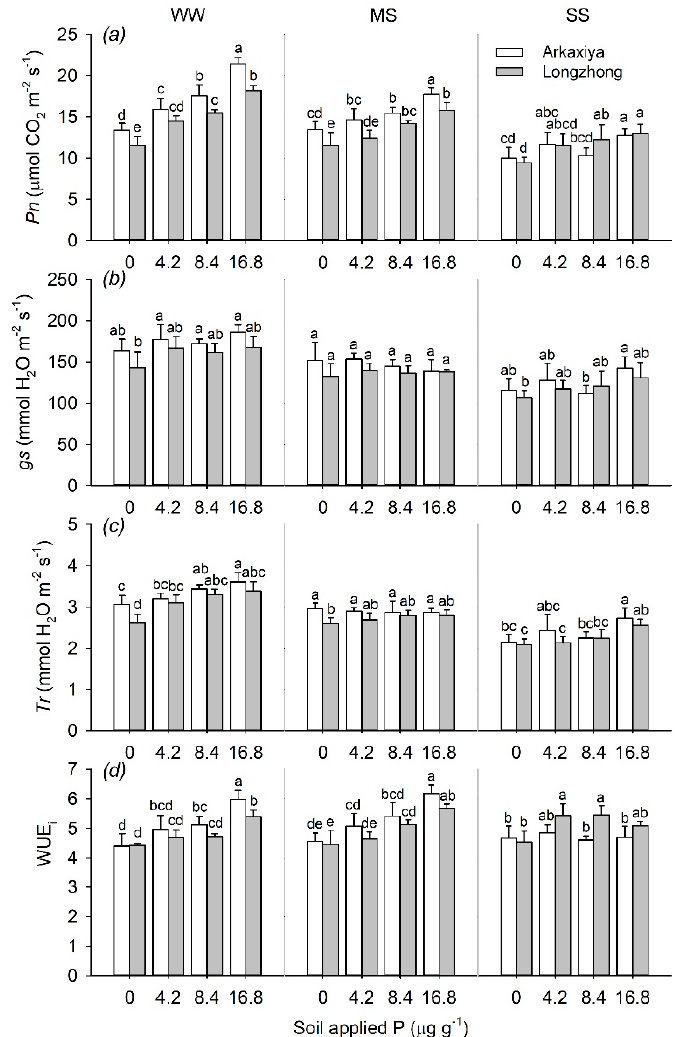
Figure 3. Changes of photosynthesis ( Pn ) ( a ), stomatal conductance ( gs ) ( b ), transpiration rate ( Tr ) ( c ) and intrinsic water use e ffi ciency (WUE i ) ( d ) of two alfalfa genotypes, Arkaxiya (white bars) and Longzhong (grey bars), grown for 10 weeks with four P supply levels and three water treatments: (i) well-watered (WW); (ii) moderate water shortage (MS); and (iii) severe water shortage (SS). Values are means + one standard error of the mean ( n = 3). Di ff erent letters between bars represent significant di ff erences between means at p <